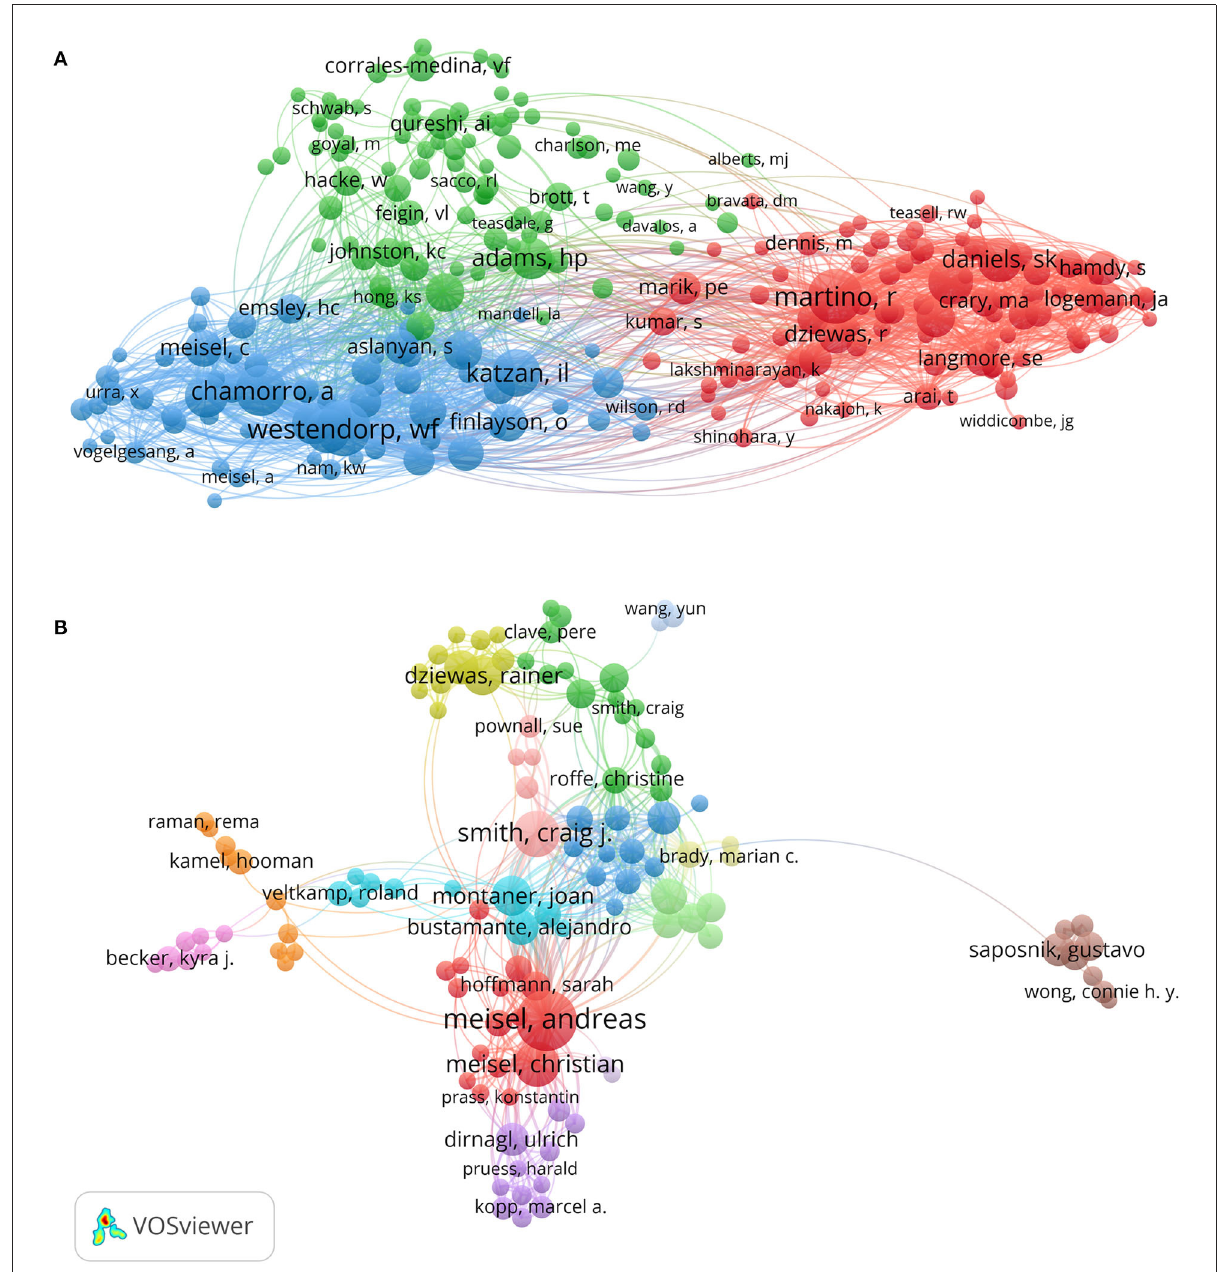
FIGURE6 The co-citation analysis (A) and the co-authorship analysis (B) of the authors participated in post-stroke pneumonia research conducted by VOS